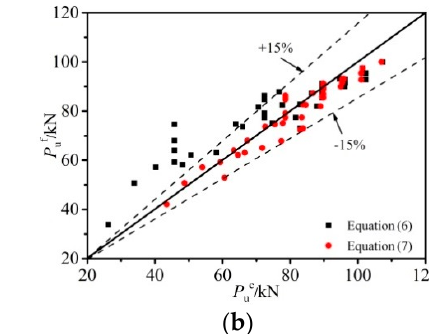
Figure 15. Comparison between predicted and FE results: ( a ) shear load at the first slip; ( b ) ultimate shear capacity.